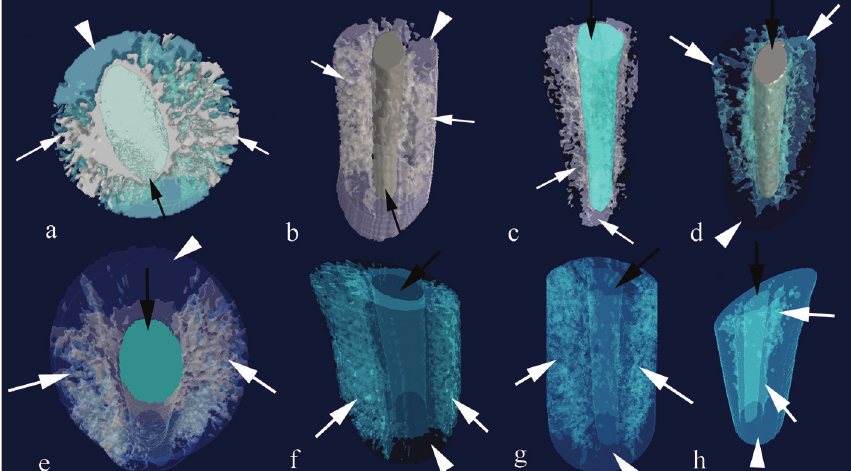
Figure 2- Micro-computed tomography (micro-CT) images showing a three-dimensional (3D) representation of AH Plus (a) and the EndoSequence BC sealer (e) in the coronal sections from an axial view. The superior penetration could be observed in the coronal (b- AH Plus, f-BC sealer), middle (c-AH Plus, g-BC sealer), and apical sections (d-AH Plus, h-BC sealer). White arrows indicate root canal sealers; black arrows indicate the gutta-percha; and the arrowheads indicate the